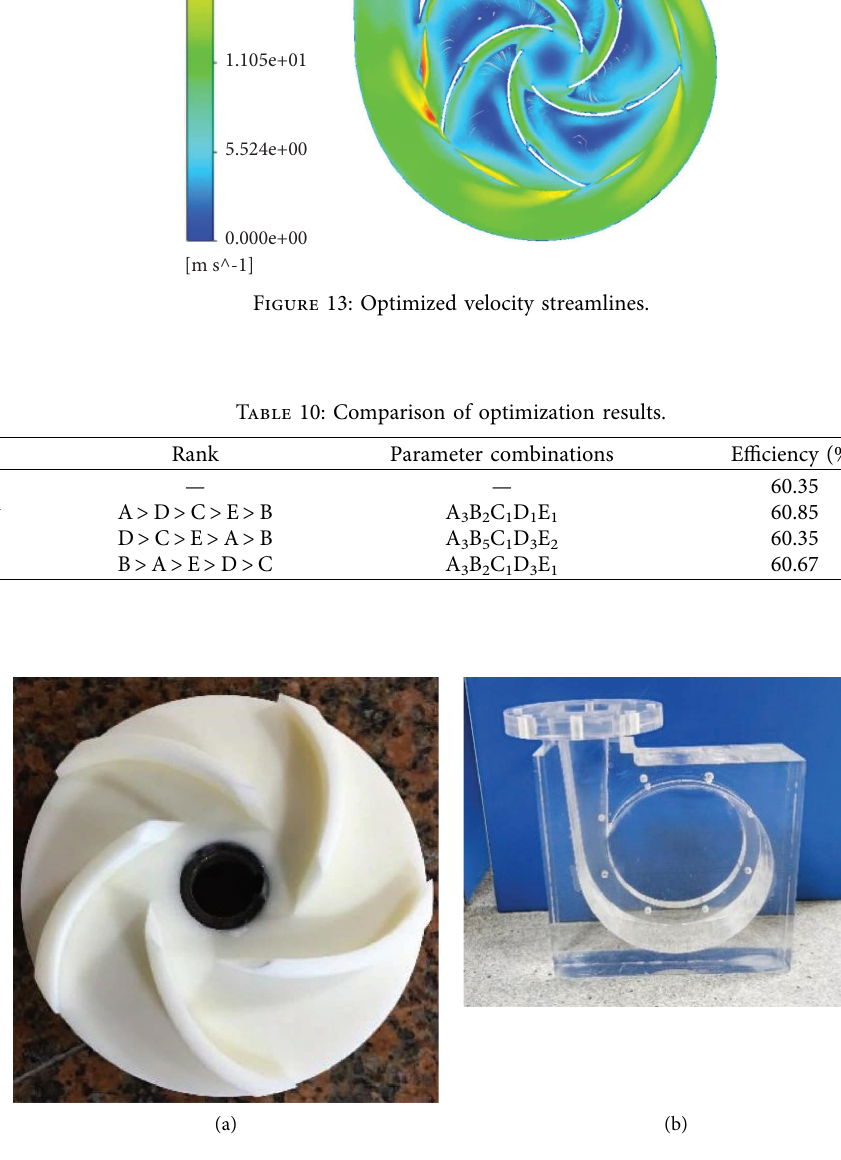
Figure 14: Overcurrent parts fgure (a) impeller and (b) volute.